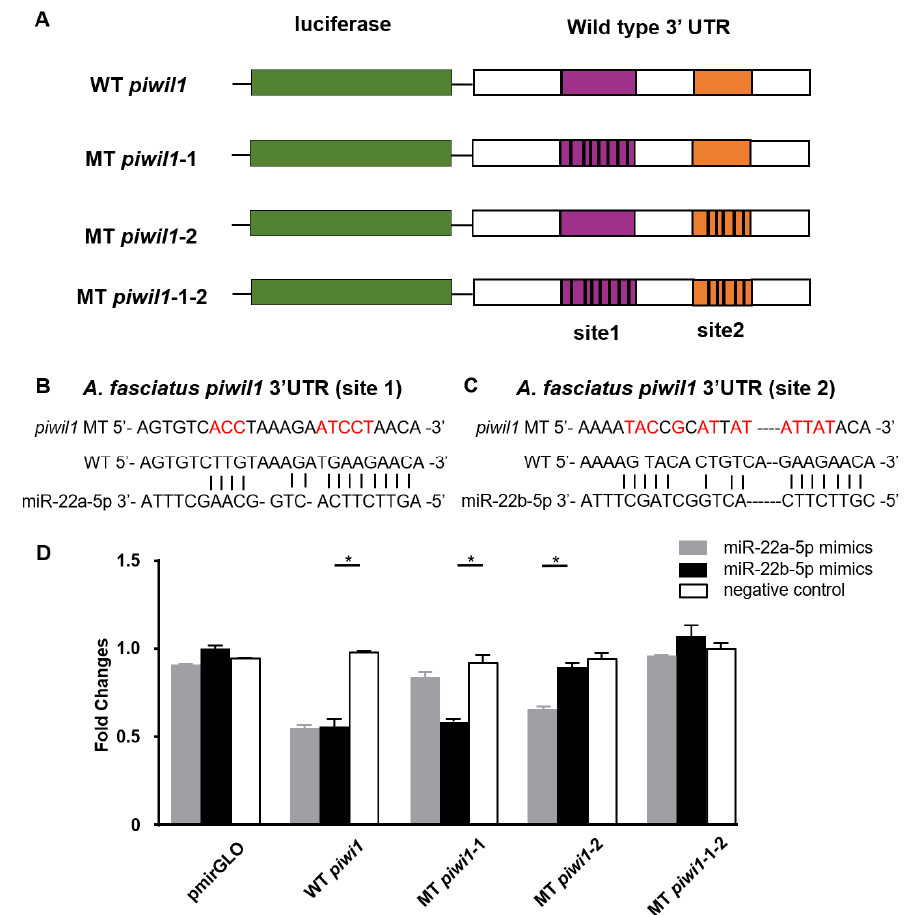
Figure 7. Prediction map of miR-22a-5p, miR-22b-5p, and piwil1 target sites and the luciferase activity. ( A ) Piwil1 target prediction map. miR-22a-5p and miR-22b-5p only have two base differences, which are basically consistent with the binding location and region of target genes. ( B ) The specific prediction diagram of miR-22a/b-5p and target genes at binding site 1 (purple area). ( C ) The specific prediction diagram of miR-22a/b-5p and target genes at binding site 2 (orange area). ( D ) The luciferase activity of miR-22a-5p, miR-22b-5p, and piwil1 . *: 0.01 < p < 0.05.